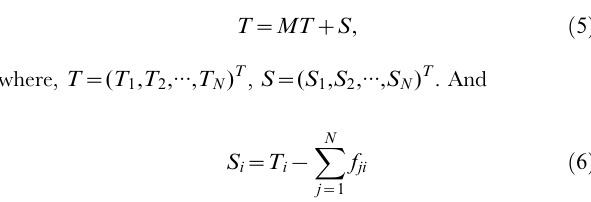
dataset. Table S7, Top ten countries of different industries in the OECD Dataset. Figure S1, Balanced value flow of one country. Figure S2, Exponents Distribution for All 4-digit Leamer Classification Standard. Figure S3, The relationship between g and the mean proportion of foreign value